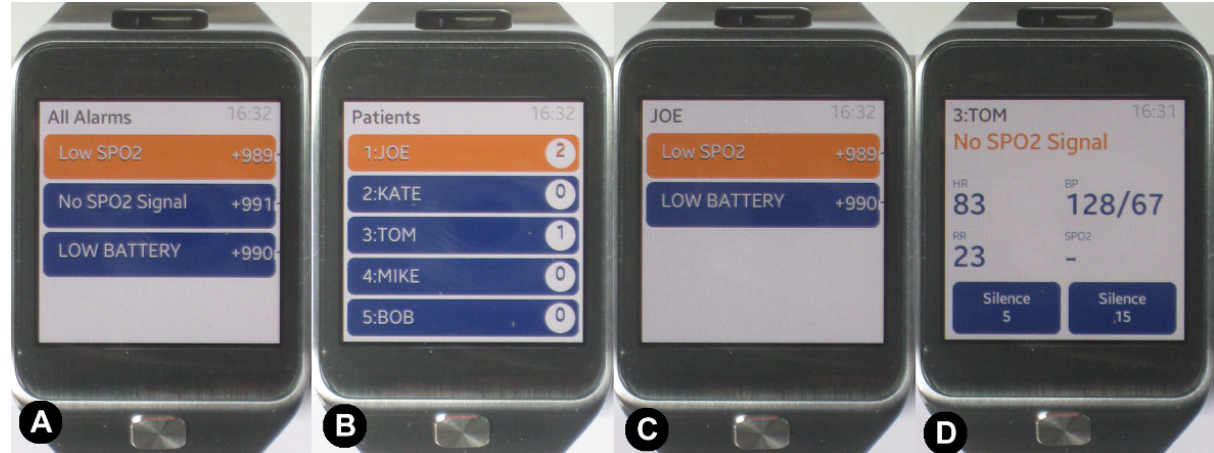
Figure 24. Alarm system app running in a smartwatch with 4 screens by McFarlan et al [38]: (A) list of all alarms related to any patient monitored by the nurse, (B) list of the 5 patients monitored by the nurse, (C) list of all alarms for a selected patient, and (D) patient view with the alarm message on the top and the values for the patient’s vital signs. The blue background indicates silenced alarms, and the orange background indicates alarms that are not